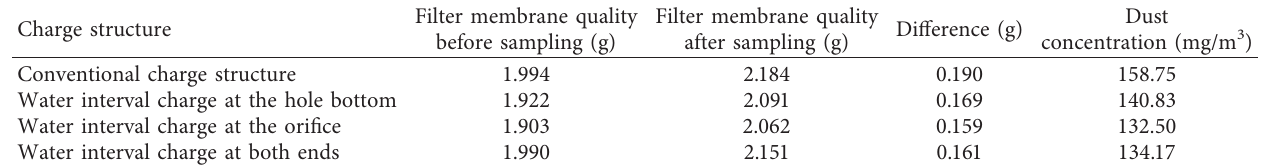
Table 7: Dust suppression effect of the four charge